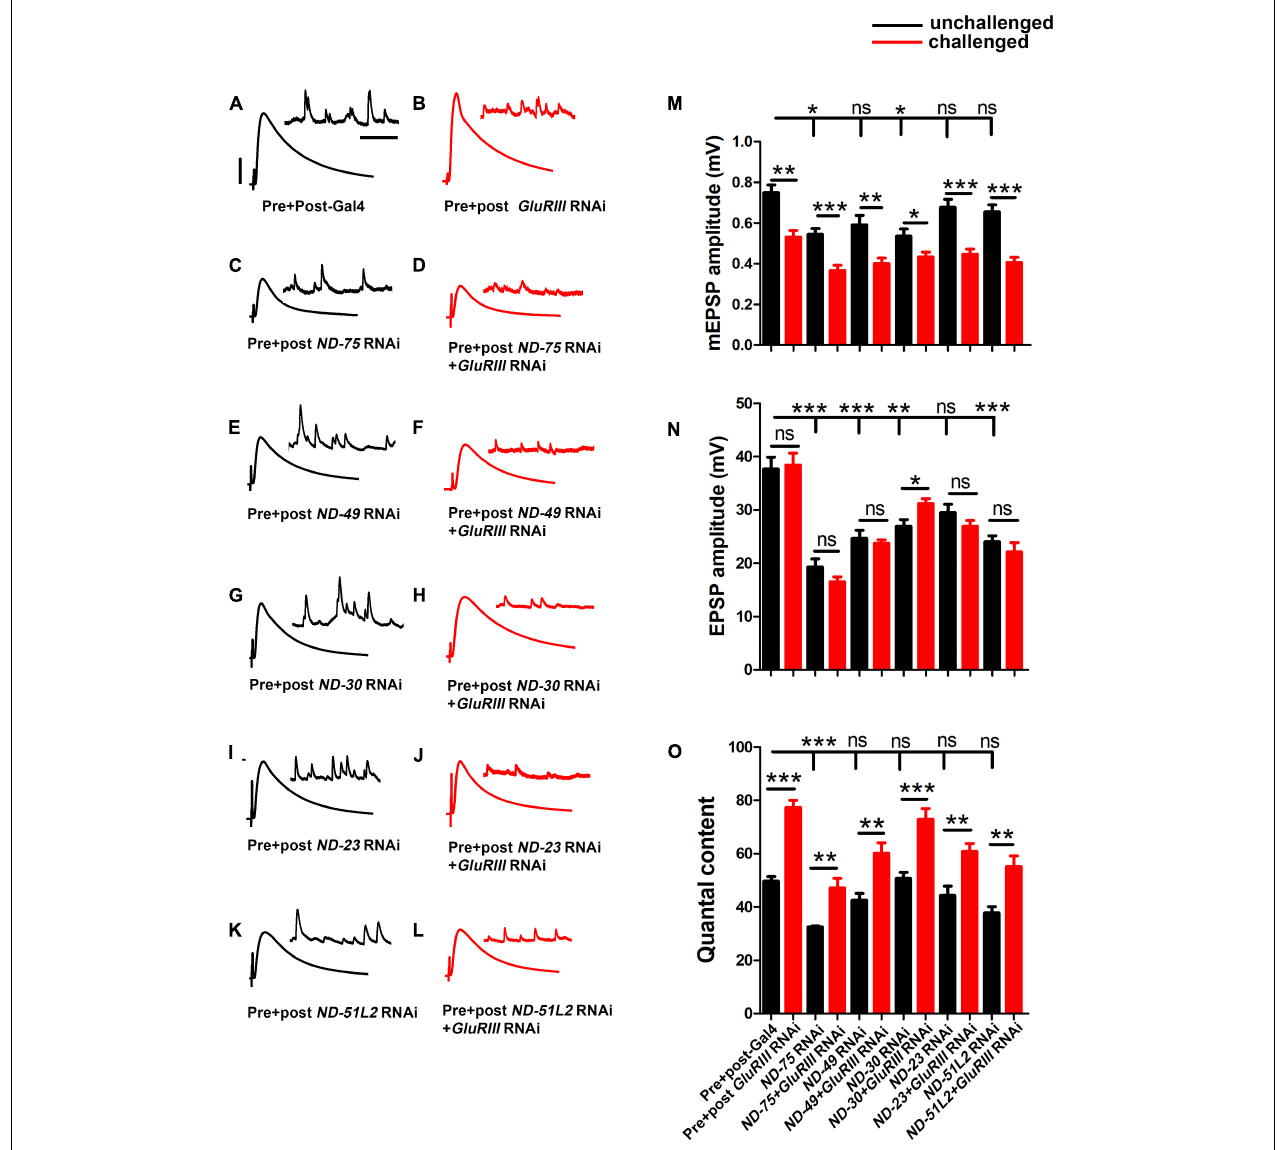
FIGURE 3 | Core complex I subunits regulate neurotransmission. (A–L) Representative traces for pre + post-Gal4 driven knockdown of Mitochondrial Complex I subunits in the presence and absence of GluRIII RNAi. Scale bars for EPSPs (mEPSPs) are x = 50 ms (1000 ms) and y = 10 mV (1 mV). (M–O) Histogram showing average mEPSP, EPSPs amplitude and quantal content in pre + post-Gal4 control, pre + post-Gal4 driven GluRIII RNAi, pre + post-Gal4 driven MCI subunits and pre + post-Gal4 driven GluRIII RNAi and MCI RNAi core subunits in the indicated genotypes. At least 8 NMJ recordings of each genotype were used